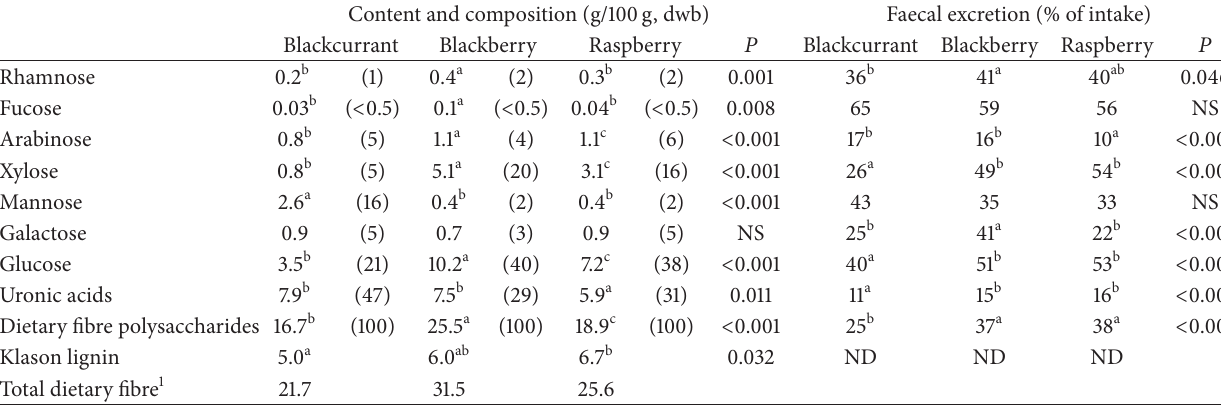
Table 2: Content (g/100g, dwb) and faecal excretion (%) of dietary fibre in rats fed a diet containing blackcurrant, blackberry, and raspberry, and L. plantarum